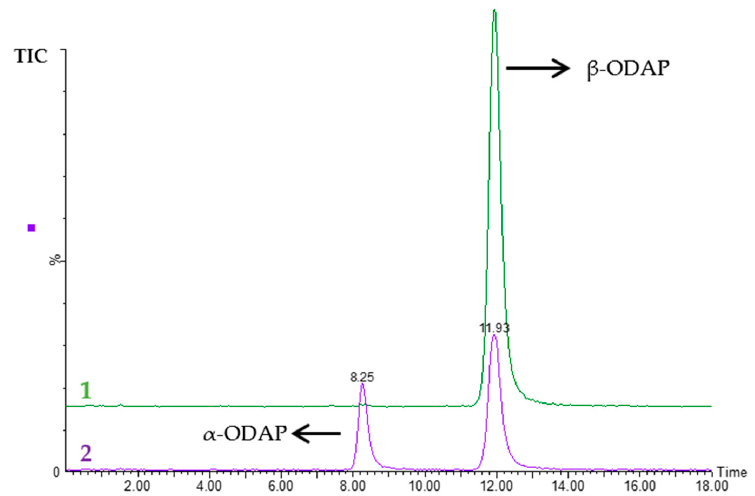
Figure 1. Representative TIC (total ion chromatogram) from MRM (multiple reaction monitoring) chromatograms ( m / z 177 > 116 and m / z 177 > 87) of (1) a fresh β - N -Oxalyl- L - α , β -diaminopropionic acid ( β -ODAP) solution at 1 mg L − 1 and (2) after isomerization to α -ODAP by heating the β -ODAP solution at 120 ◦